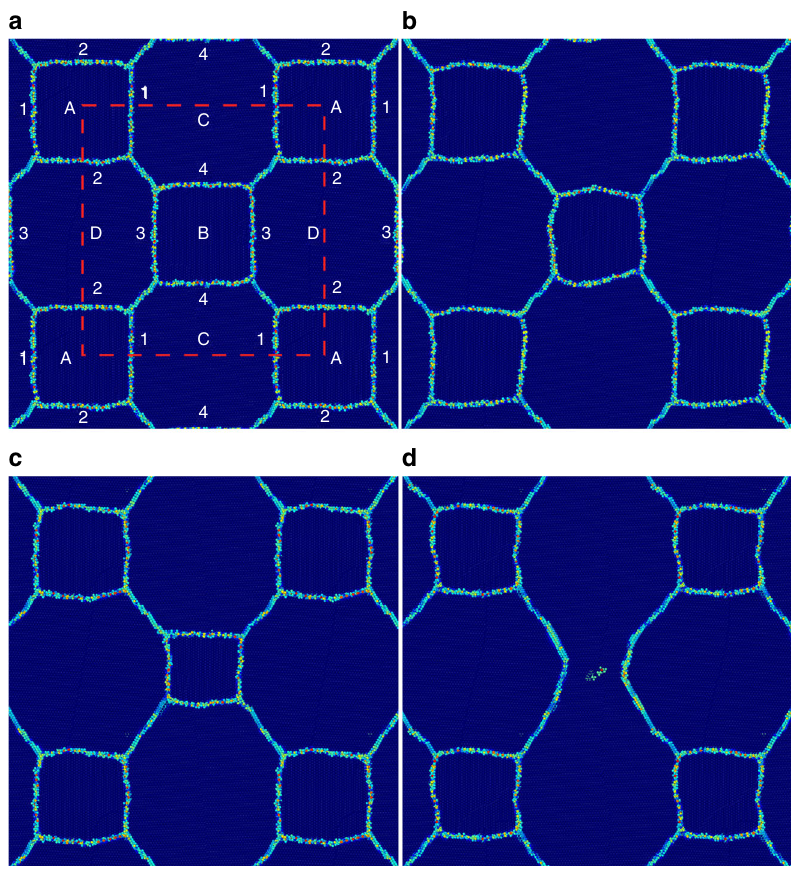
Fig. 3 Idealized polycrystalline microstructure. Time Evolution of the columnar 3D microstructure. a Initial microstructure with grain and GB labels. The dashed red line indicates the periodic simulation cell. Crystallographic details are provided in Supplementary Table 1. b – d Evolution of the microstructure in a For a full animation of this simulation, see Supplementary Video